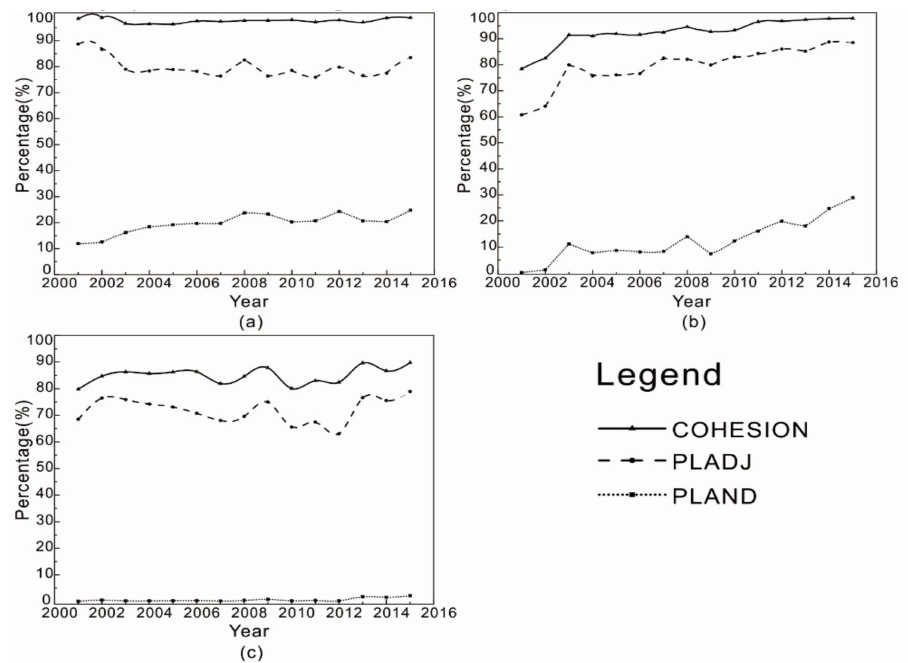
Figure 5. The dynamics of strong heat islands’ landscape in typical cities: ( a ) Beijing; ( b ) Shijiazhuang; and ( c )